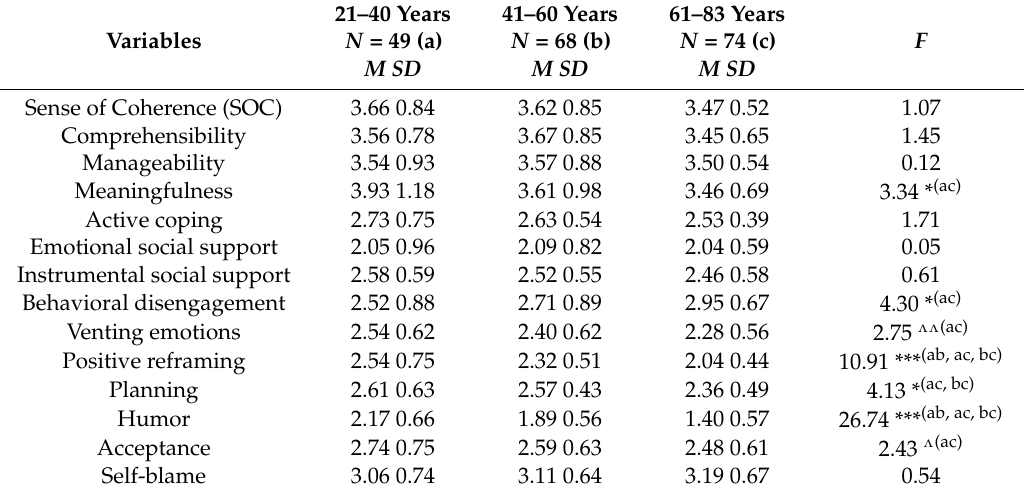
Table 1. Means and standard deviations of the study variables among the three age